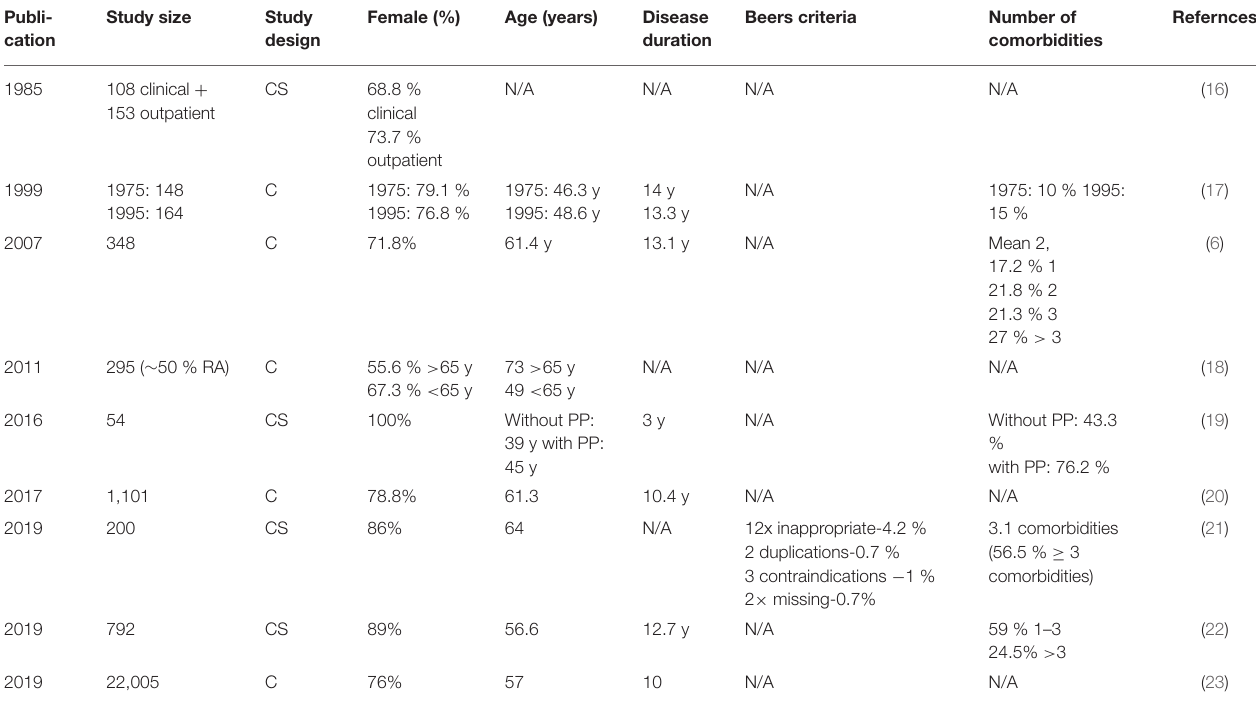
TABLE 1 | Study characteristics from the literature review with Beers criteria as available (ordered according to year of publication). Publi- Study size Study Female (%) Age (years) Disease cation design